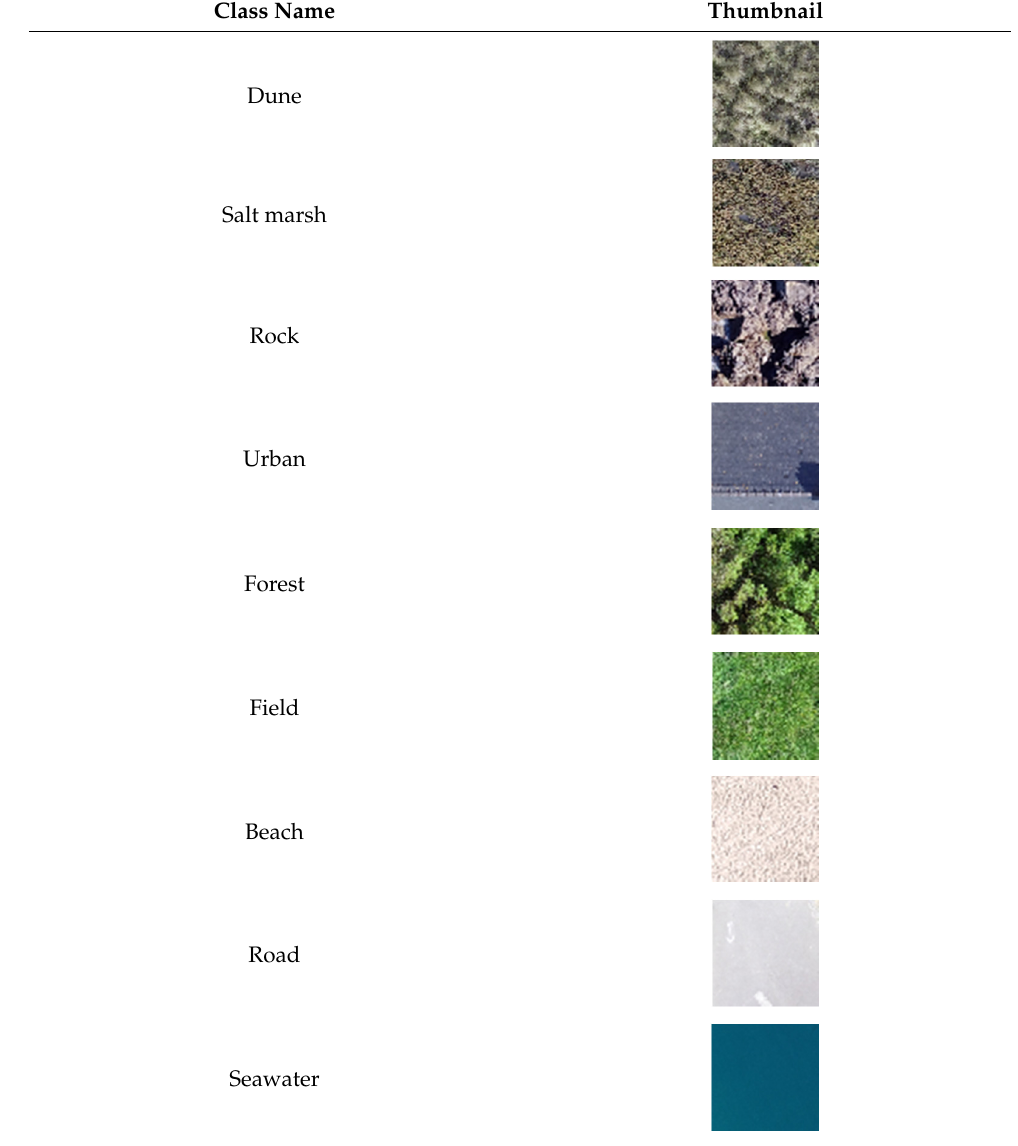
Table 2. Pleiades–1 natural–coloured thumbnail of the nine coastal landscape classes.